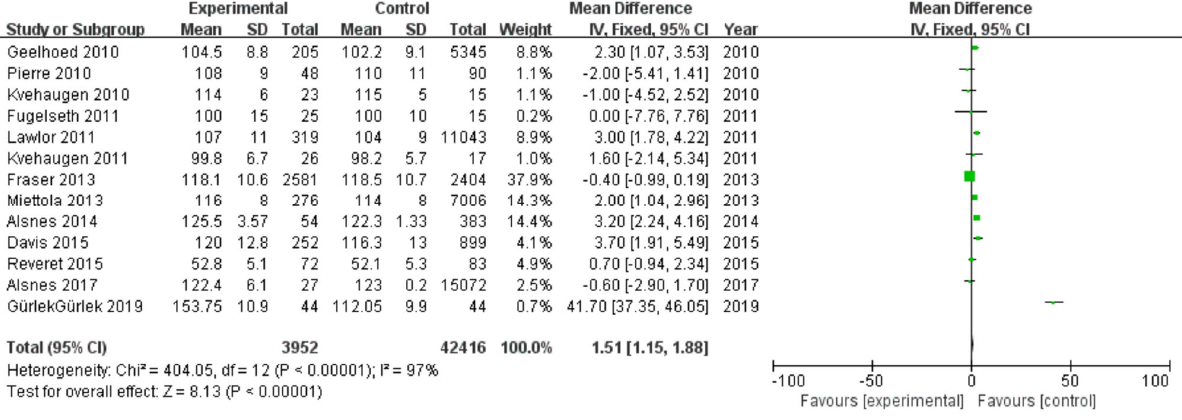
Figure 2. Meta-analysis forest map for total cholesterol of offspring of PE Figure 2. Meta ‐ analysis forest map for systolic blood pressure of offspring of PE pregnancies.